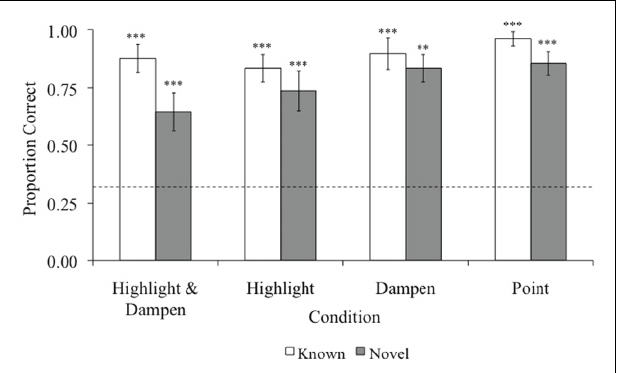
FIGURE 2 | Children’s proportion of correct choices during the referent selection task. Dotted line represents chance (0.33). Error bars represent 1 SE. *** p < 0.001, ** p < 0.02.